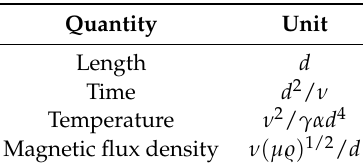
Table 2. Units of non-dimensionalisation.